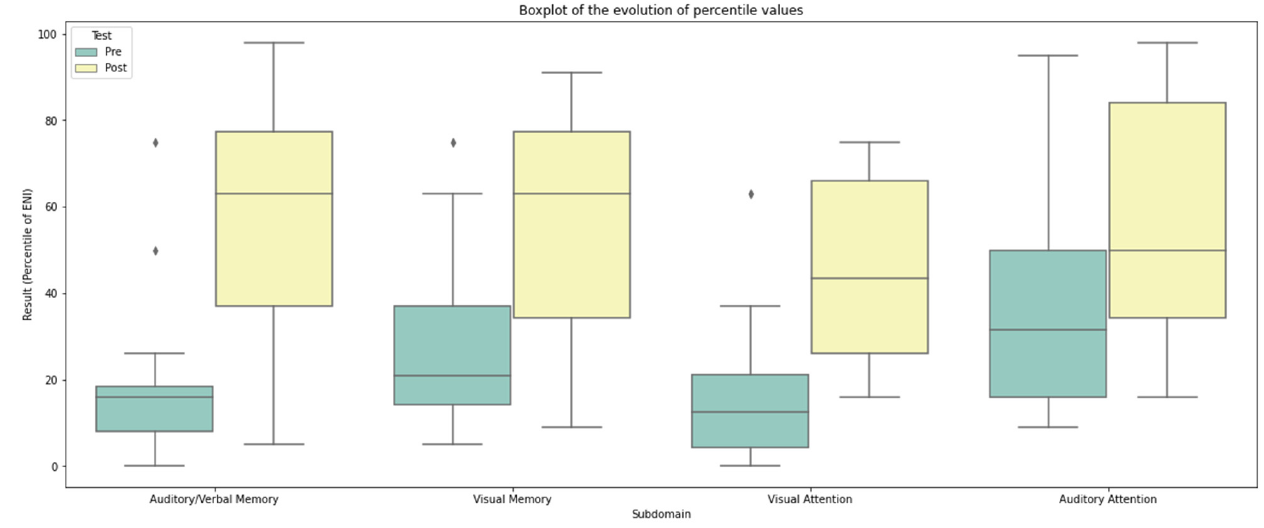
Figure 5. Evolution of percentile values in each subdomain.